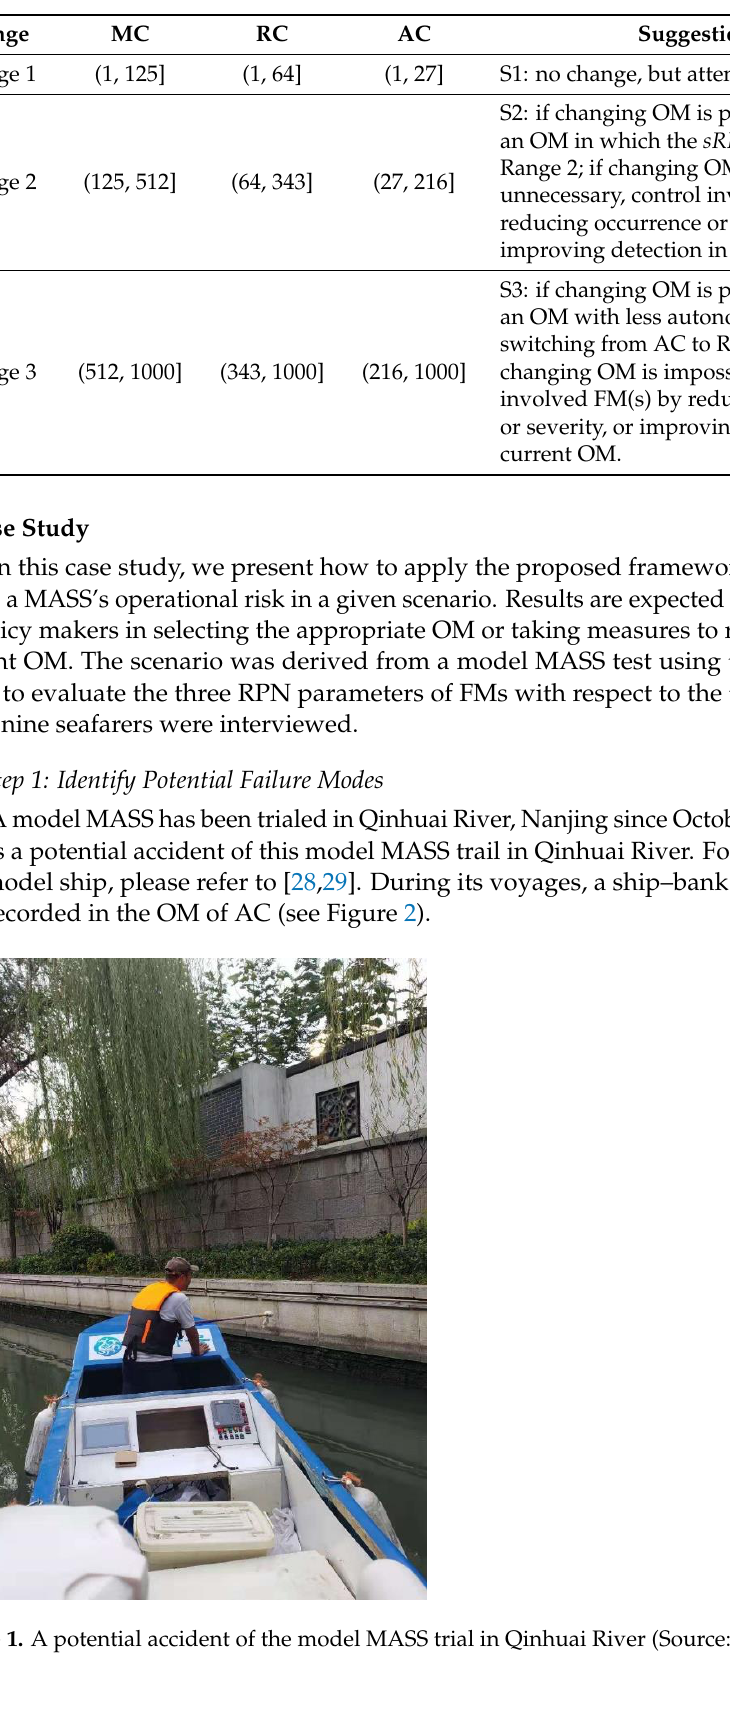
Table 5. Suggestions for changing OM.